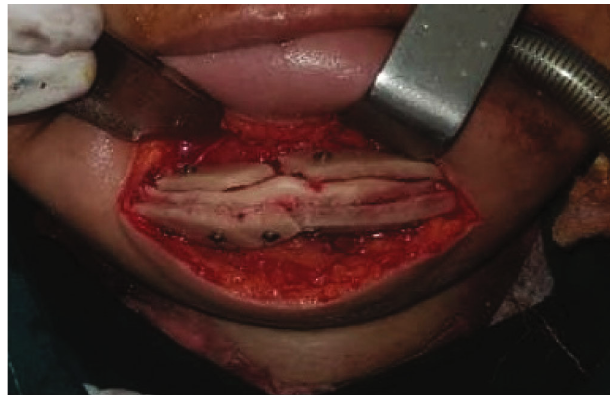
Figure 2: Grafts and lag screws — anterior